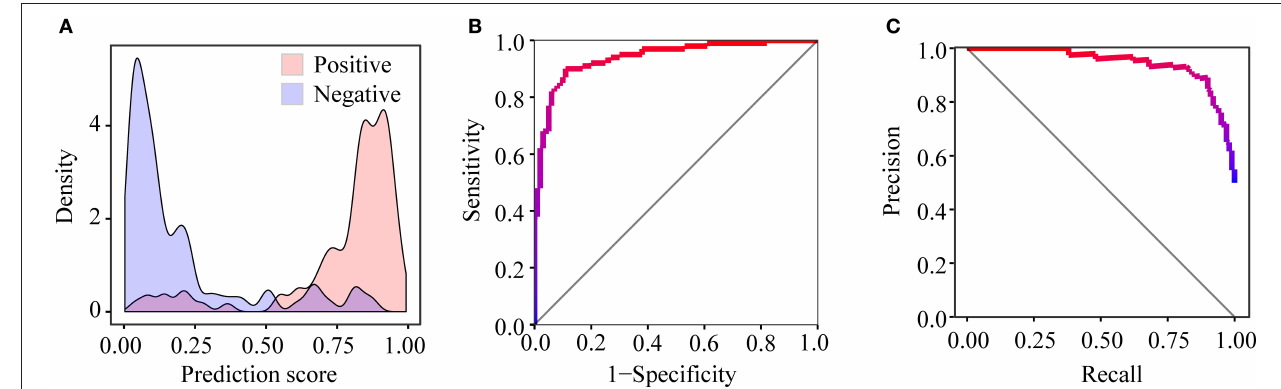
FIGURE 6 | Performance evaluation of PEA-m5C on the DatasetHT. (A) The different distribution of prediction scores for positive and negative samples. (B) The ROC curve illustrating the high performance of PEA-m5C. (C) The precision-recall curve illustrating the high performance of PEA-m5C.